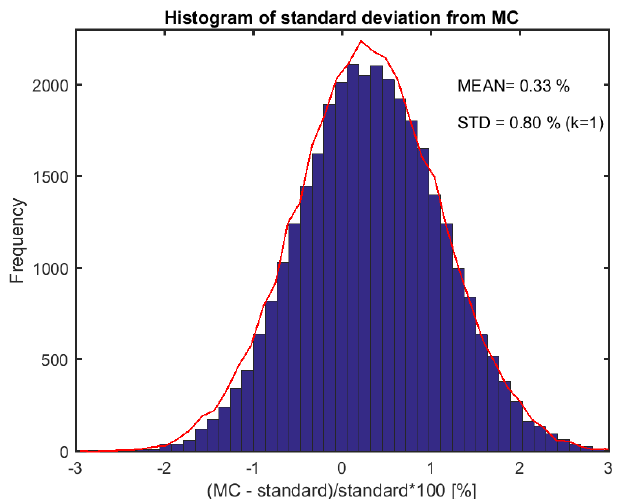
Figure 6. Histogram of all realizations from the Monte Carlo (MC) simulation indicating an overall uncertainty of 0.8% (standard de- viation of differences) of traceable TCO measurements with QA- SUME. The red line indicates a randomly generated Gaussian dis-